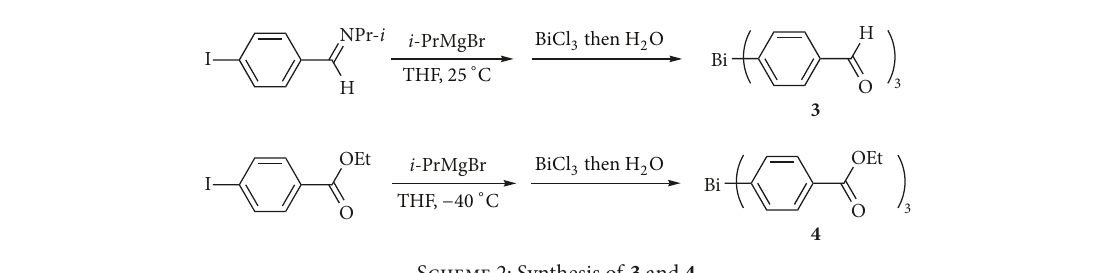
Scheme 2: Synthesis of 3 and 4